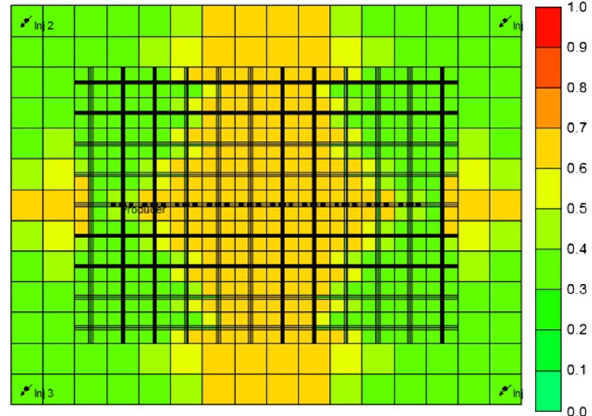
Fig. 6 Dynamic capillary pressure distribution after the production for 14 years